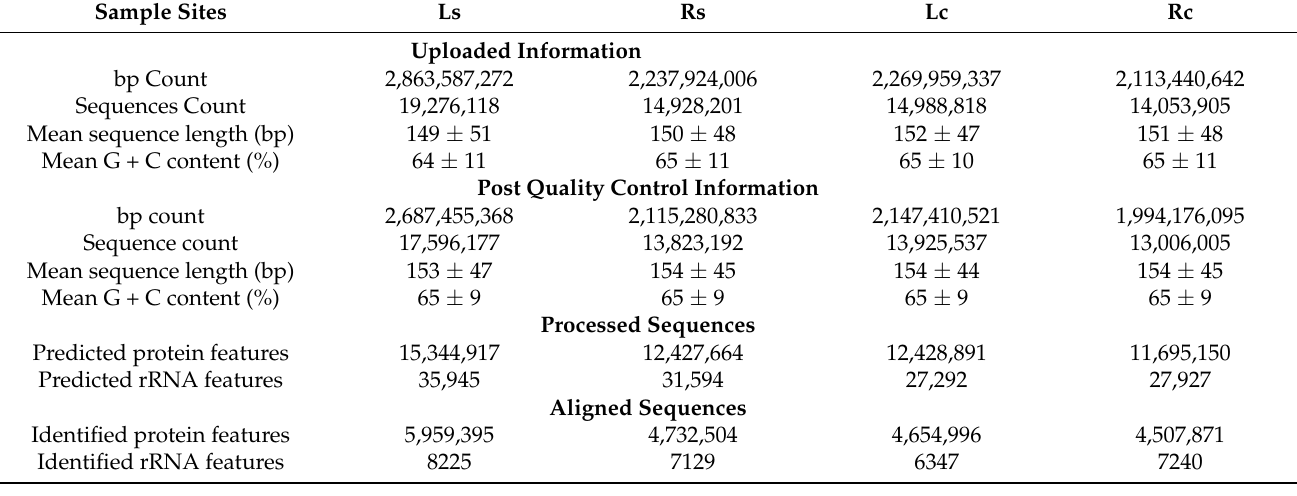
Table 2. Raw sequence and quality-filtered data based on metagenomics rapid annotations using subsystems technology.